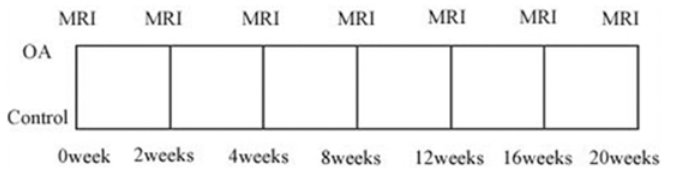
Fig 1. The overview chart of the design in this study. MRI scanning was evaluated at different time points and histologic analysis was assessed at the same time (black arrows). ACLT = Anterior cruciate ligament transection. Control = Control group. n = 18 for ACLT and control